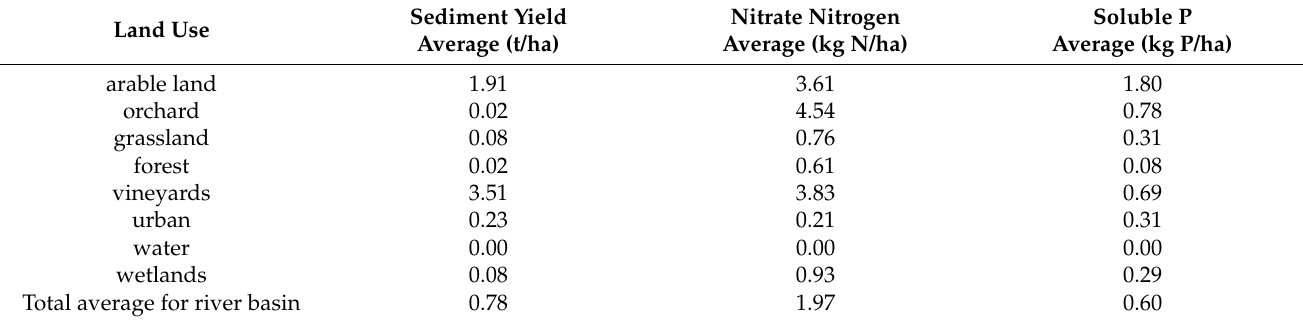
Table 3. Numerical modelling average HRU results for the BASE MODEL study period between 2004 and 2014